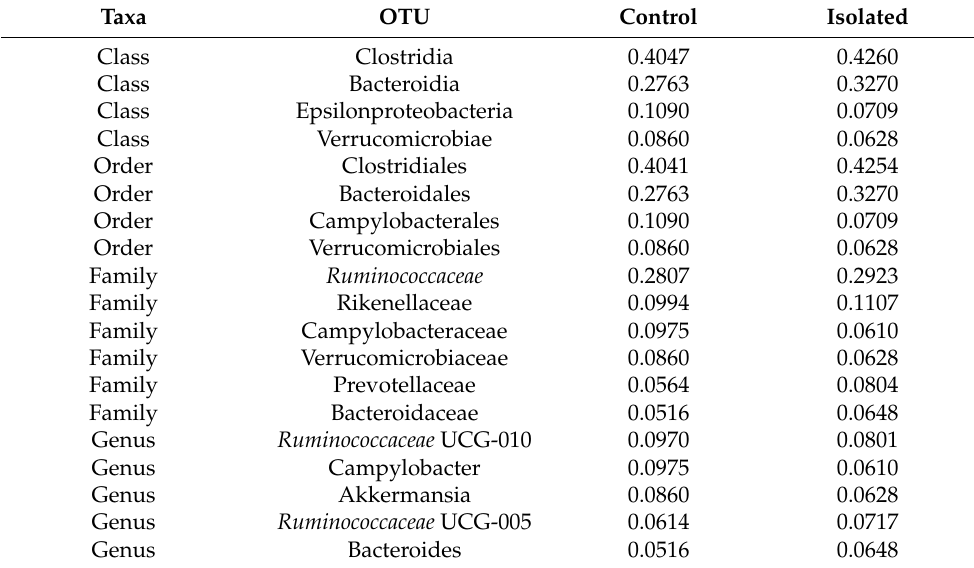
Table 2. Class to genus level of the sheep hindgut microbiome in the two groups (isolated, control). Relative abundances. OTU: operational taxonomic